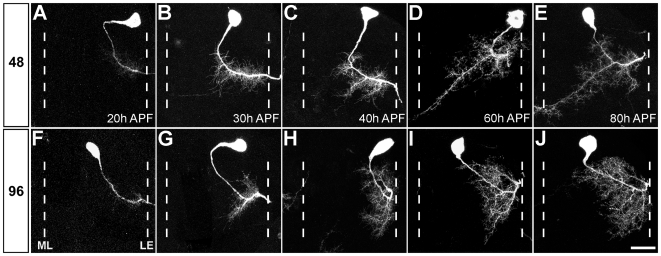
Central projections of leg motoneurons acquire their subtype-specific morphology by targeted dendritic growth.Single z-projections of leg motoneurons born following heatshocks at 48 h AH (A–E) and 96 h AH (F–J) (n = 4 for each). (A, F) At 20 h APF filopodia can be seen on the primary neurites of both neurons. (B, G) At 30 h APF the 48 h AH neuron generates filopodia and small branches that extend into the intermediate territory; a similar quantity of branches can be seen on the 96 h AH neuron in two growth zones at the lateral edge of the neuropil. (C, H) By 40 h APF the dendrites of both neurons have increased in size and higher order branches are beginning to be established. The 48 h AH neuron elaborates a branch on the anterior part of the primary neurite and also at two sites where the posterior branches will form. The 96 h AH cell has branches projecting to the anterior and posterior at the lateral edge of the neuropil. (D, I) By 60 h APF both neurons have increased their number of higher order branches. The major posterior branch in the 48 h AH neuron has reached the midline but not crossed it. The 96 h AH cell covers a large part of the lateral neuropil; many branches orient towards the midline but these never extend into medial territories. (E, J) At 80 h APF the morphology of both neurons are indistinguishable from those seen in the adult. Anterior is up. The relative positions of the midline (ML) and lateral edge (LE) of neuropil were determined by neuroglian staining. Scale bar = 20 µm.